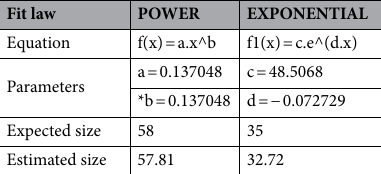
Table 1. Naegleria species pan-genome overall statics. *The parameter B pan (b) = 0.137048. The pan genome is still open but may be closed soon.